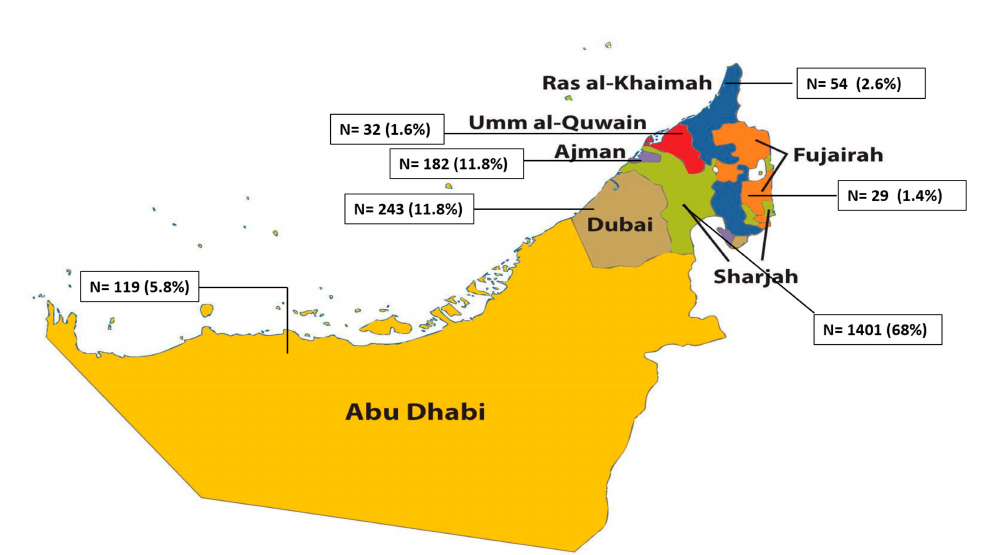
Figure A1. Illustration representing the distribution of the study sample across the map of the UAE.